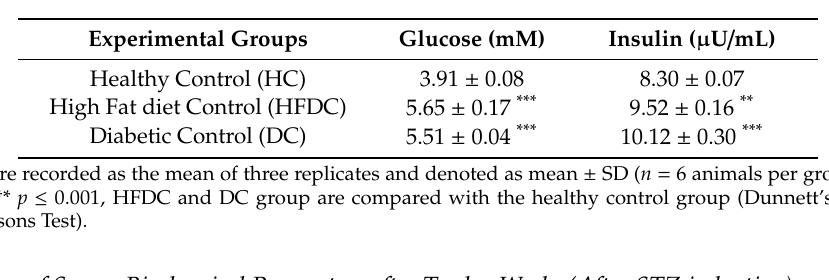
Table 1. Estimation of serum glucose and